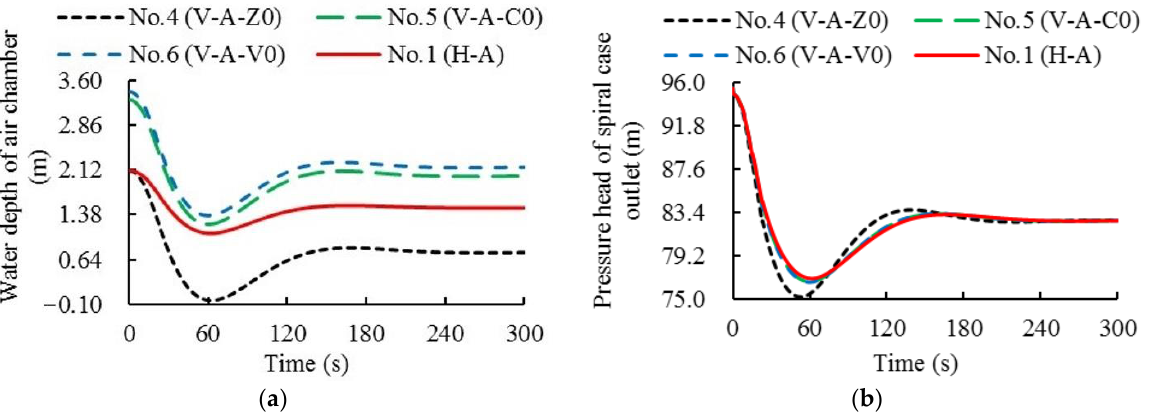
Figure 3. Comparison of horizontal and vertical ACSCs under load acceptance condition A: ( a ) Water depth varying with time; ( b ) Pressure at the end of spiral case varying with time.